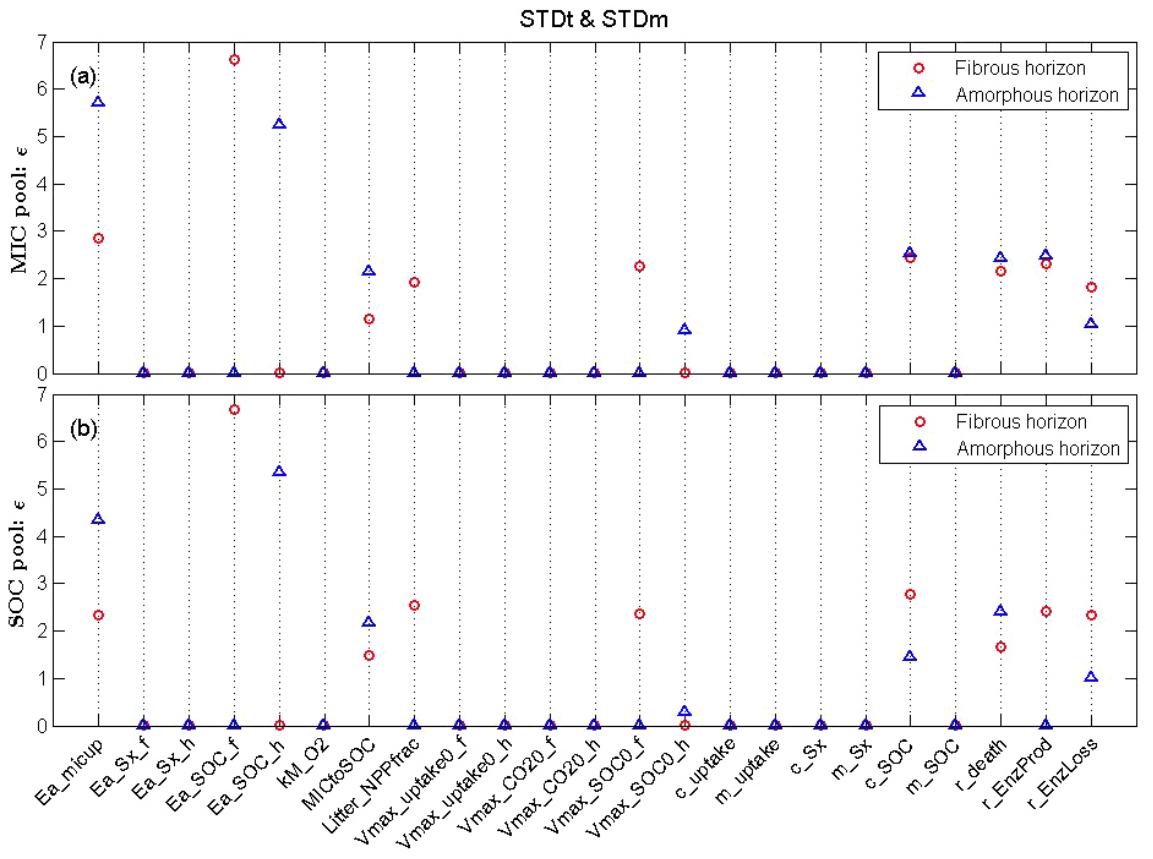
q + σ µ ∗ ) for (a) microbial biomass C pool (MIC) and (b) soil organic C pool EE 2 EE 2